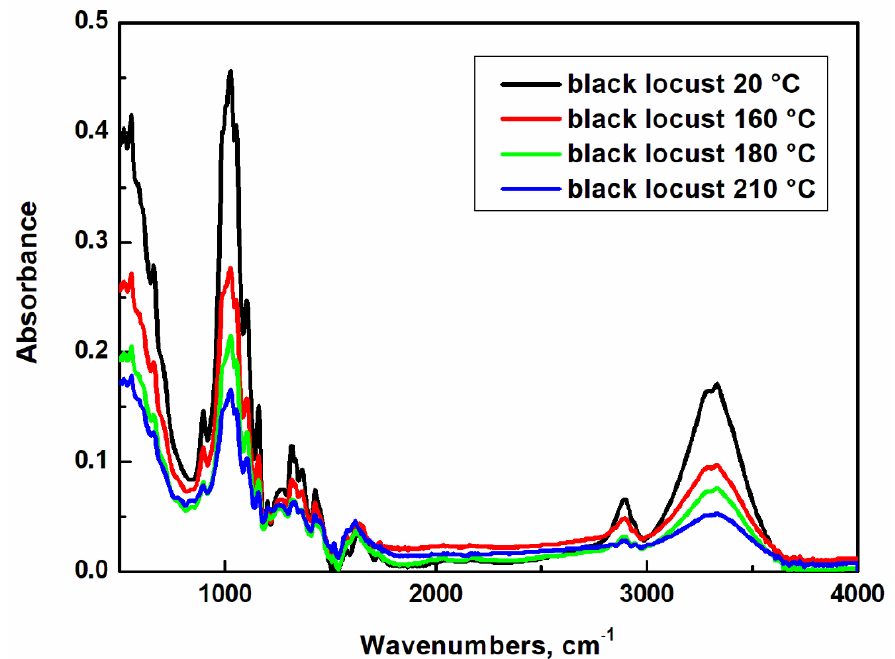
Figure 7. The region of FT-IR spectra of cellulose with the crystallinity-related bands corresponding to reference and thermally modified samples after being isolated from black locust wood.